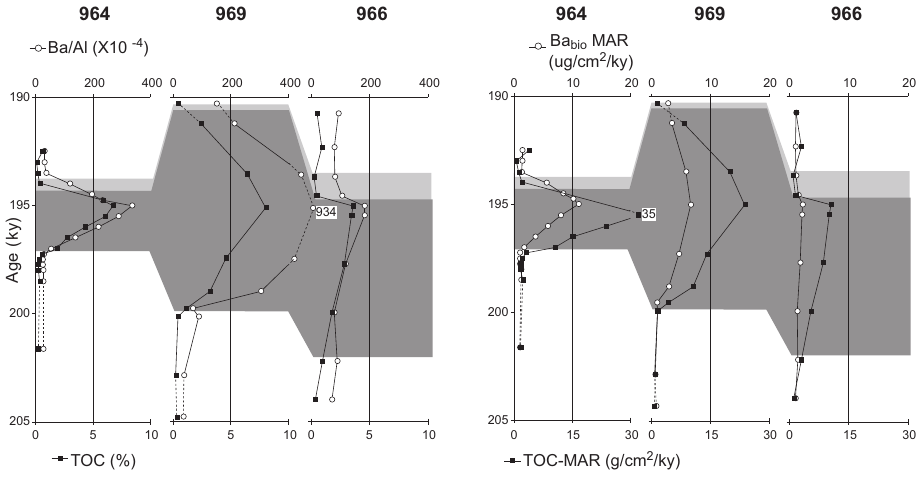
Fig. 5. Comparison of TOC and Ba/Al vs. TOC-MAR and Ba bio MAR for S7 on three studied sites. Dark shade corresponds to visible sapropel layer. Light shade represents oxydized sapropel. Maximum values off-scale are shown on the graph.